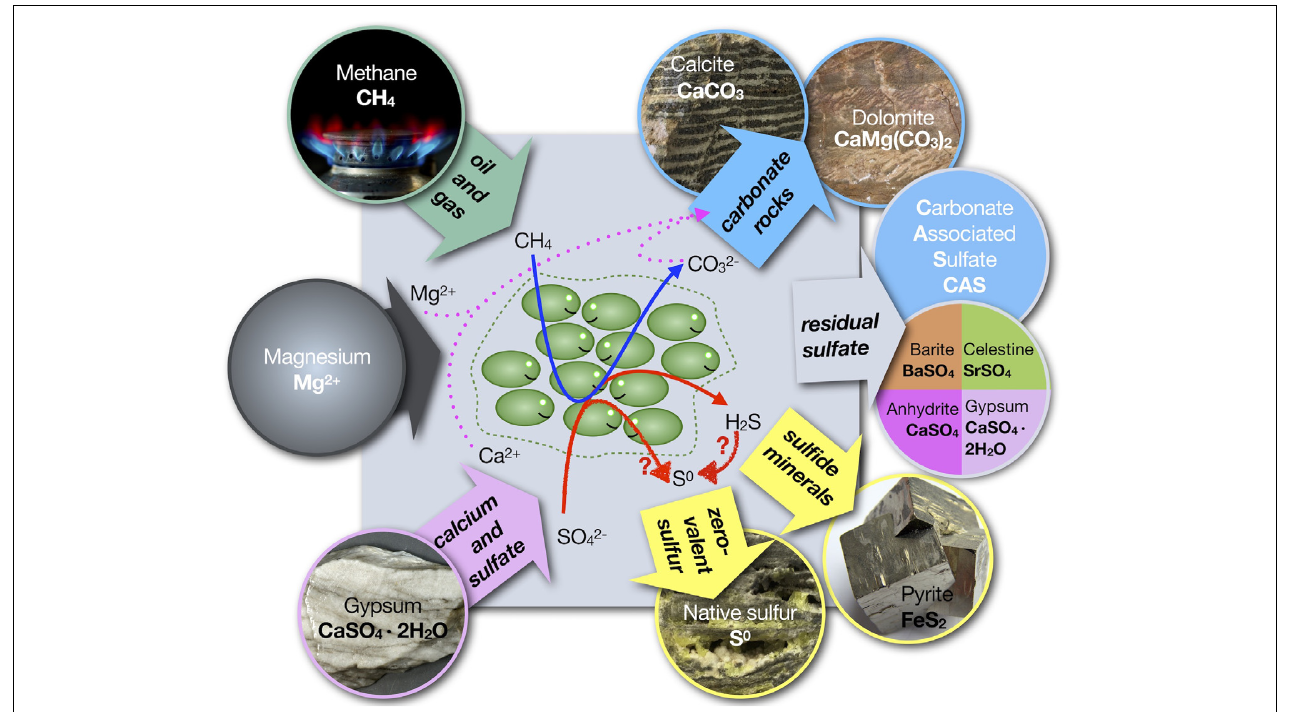
FIGURE 2 | Schematic of genesis of sulfide, native sulfur and carbonate minerals from hydrocarbons and calcium sulfate minerals. The red arrows with question marks indicate that native sulfur is either formed by an unknown microbial pathway or that an unknown oxidant is needed for the conversion of sulfide into native (zero-valent) sulfur. In cases where dolomite is formed, there must be a (unknown) source of magnesium. Dissolved sulfate in system (gray box) can become trapped in newly formed carbonate minerals as carbonate associated sulfate